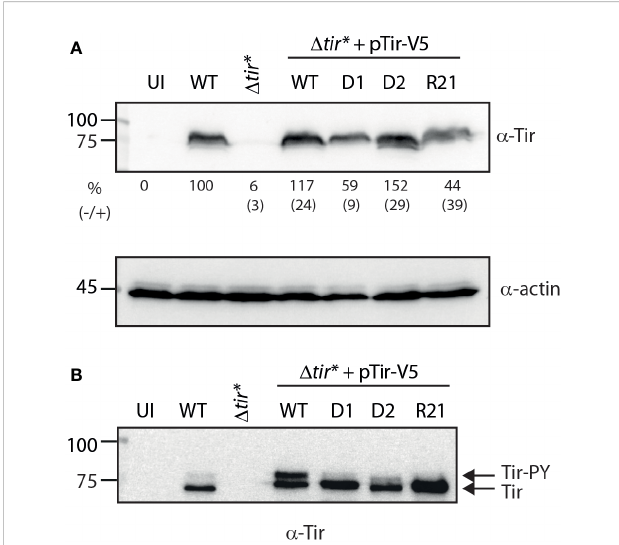
FIGURE 4 Replacement of TMD2 reduces the levels of phosphorylated Tir within the membrane fraction. (A) HeLa cells were infected with WT, D tir *, and EPEC D tir * expressing Tir wt -V5, Tir- D1 -V5, Tir- D2 -V5, or Tir- R21 -V5 for 3 h or left uninfected (UI). The cells were washed and lysed using PBS with Triton X-100. Cell lysates were subjected to western blot with anti-Tir and anti-actin (control) antibodies. The average values and standard errors of Tir translocation level as a percentage of translocated Tir observed for WT EPEC (from three independent experiments) are presented along a representative blot. (B) The membrane fractions of HeLa cells infected with the various bacterial strains were subjected to western blot with anti-Tir